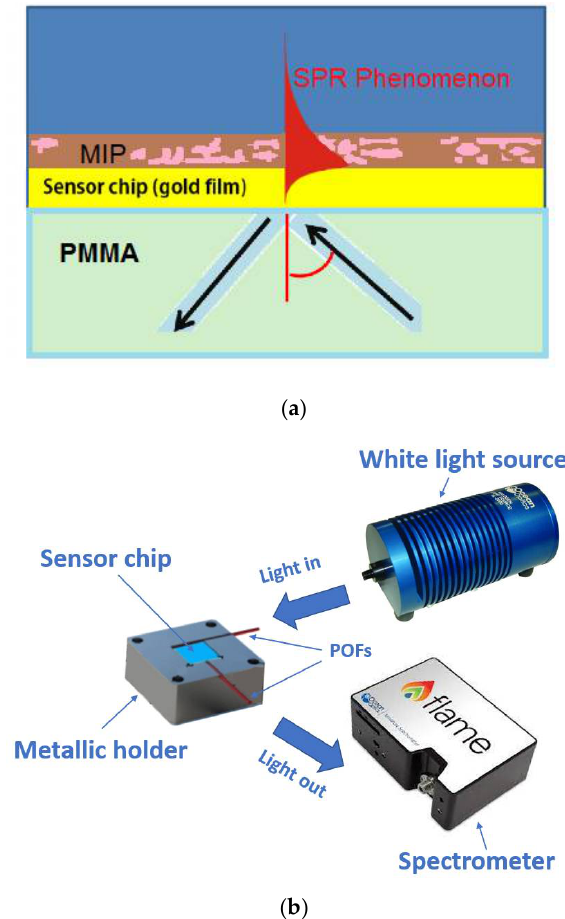
Figure 1. ( a ) Outline of the sensor chip cross-section. ( b ) Experimental setup